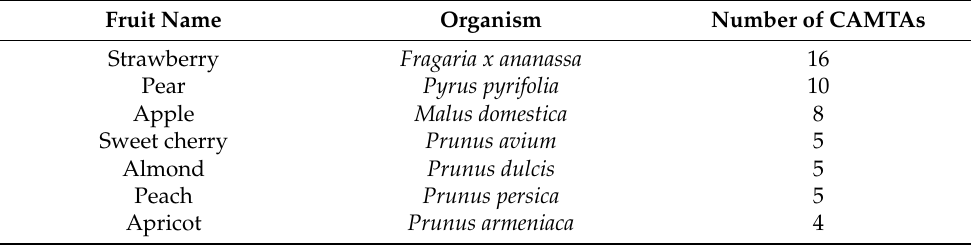
Table 2. The number of CAMTA genes in fruit crops from Rosaceae